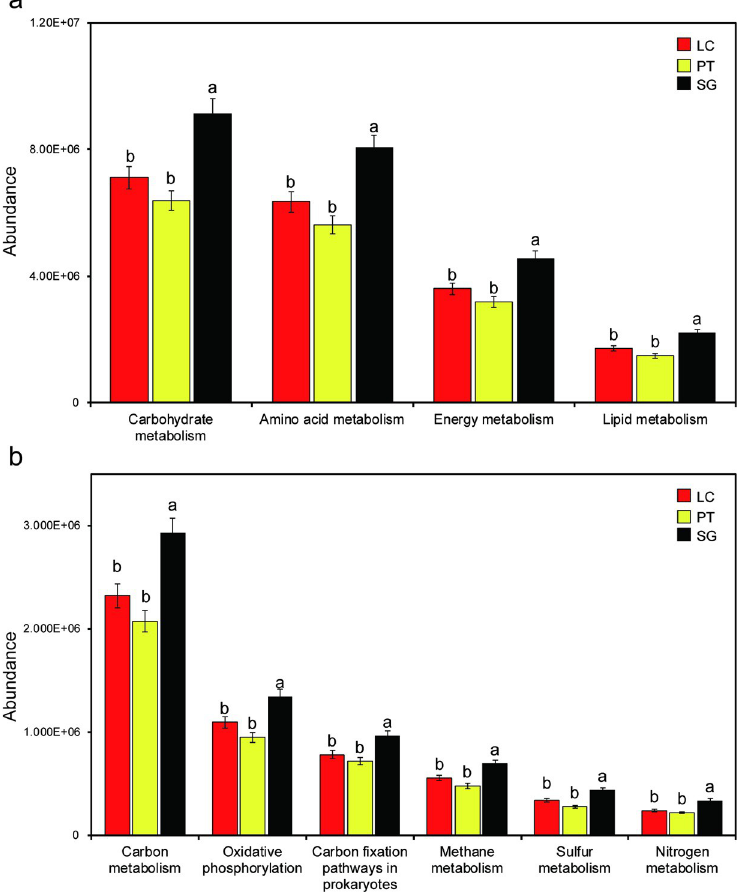
Fig 6. Predicted functions of the soil bacterial community using PICRUSt at KEGG function classification pathway Level2 (a) and pathway Level3 (b). Different lowercase letters into each column are significantly different (Tukey’s test, P < 0.05). LC, Leymus chinensis (Trin.) Tzvel.; PT, Puccinellia tenuiflora (Griseb.) Scribn. et Merr.; SG, Suaeda glauca (Bunge) Bunge.